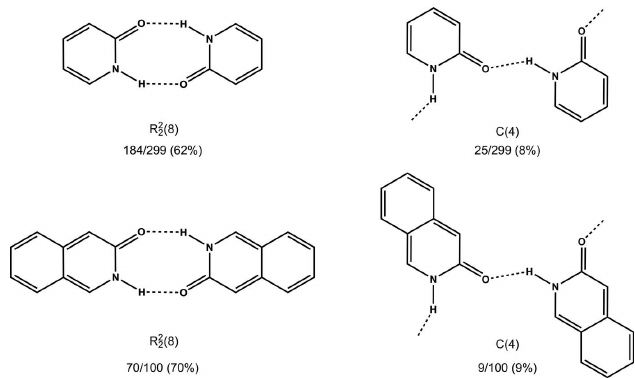
Figure 11 A survey of the CSD revealed a pronounced tendency for R 2 formation for the pyridine- and quinoline-type fragments in purely organic solids.